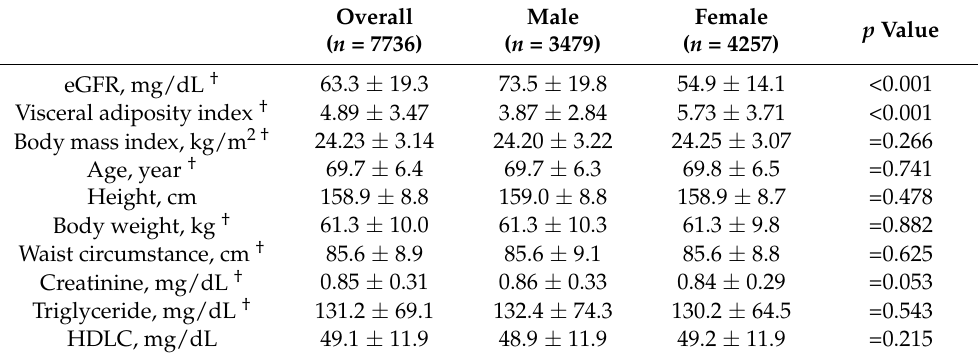
Values are means ± SD. eGFR = estimated glomerular filtration rate; HDLC = high density lipoprotein cholesterol. † Mann–Whitney U test was applied to assess the difference between groups. Sex-specific differences and trends in the VAI and BMI according to eGFR category are presented in Figure 2. For the male subjects, the trend test revealed a significant decreasing tendency in the eGFR across the groups (from N to MS CKD; standardized statistic (SS) = − 46.75, p < 0.001), while the opposite tendency was observed for the VAI and BMI (SS = 8.25 and 2.78, respectively; p < 0.01 for both). Post-hoc tests demonstrated that the VAI could discriminate among the N, M CKD, and MS CKD groups. The BMI could distinguish between the N and MS CKD groups, but not between the N and M CKD or M CKD and MS CKD groups. For the female subjects, the trend test revealed a significant decreasing tendency in the eGFR across groups (from N to MS CKD; SS = − 68.56; p < 0.001), while the opposite tendency was found for the VAI and BMI (SS = 9.78 and 2.48, respectively; p < 0.05 for both). Post-hoc tests revealed that the VAI could discriminate among the N, M CKD, and MS CKD groups. The BMI could distinguish between the N and M CKD groups and N and MS CKD groups, but not between the M CKD and MS CKD groups. Table 2 shows the sex differences in parameters essential to calculate the VAI, BMI, and eGFR, such as the waist circumference, height, weight, BMI, TG, HDLC, creatinine levels, and age. Table S2 shows the results of analyses of additional parameters.